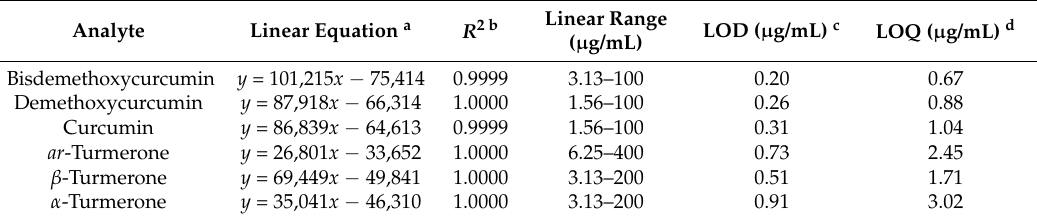
Table 1. Calibration curves, limits of detection (LODs), and limits of quantification (LOQs) of the six